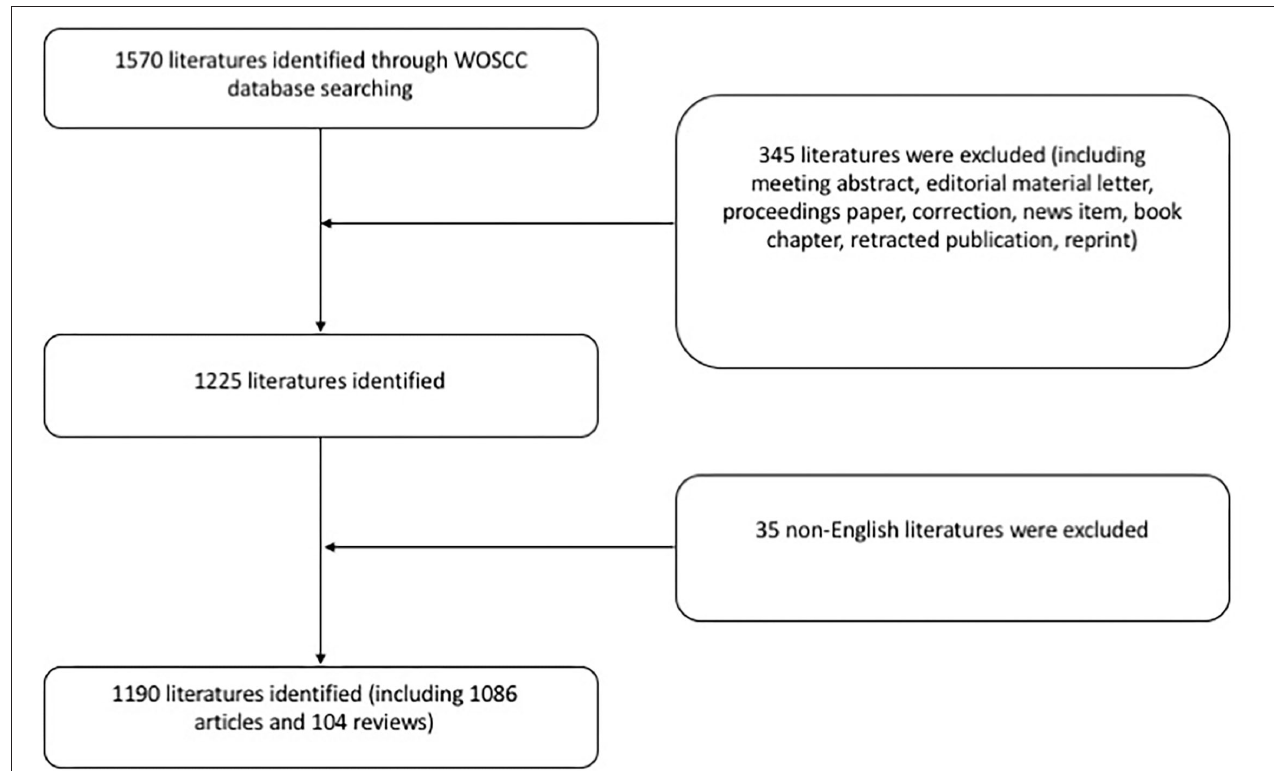
FIGURE 5 | Flow chart of the search strategy of our study. Only English articles and reviews were